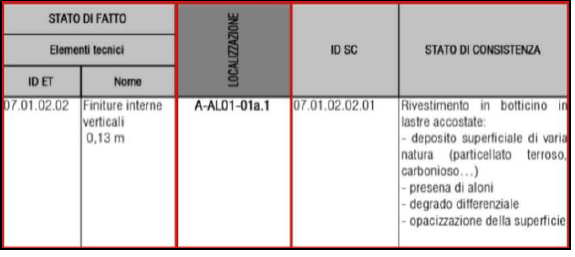
Figure 9. Information added to the generic WBS